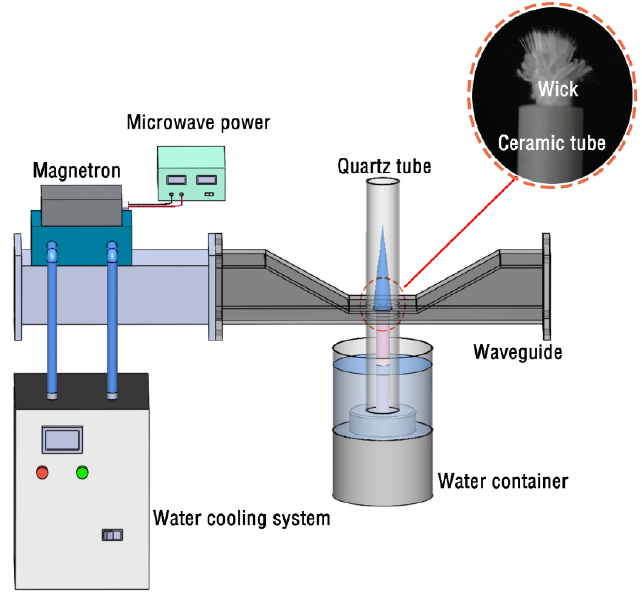
Figure 1. Schematic of the water vapor microwave plasma setup.